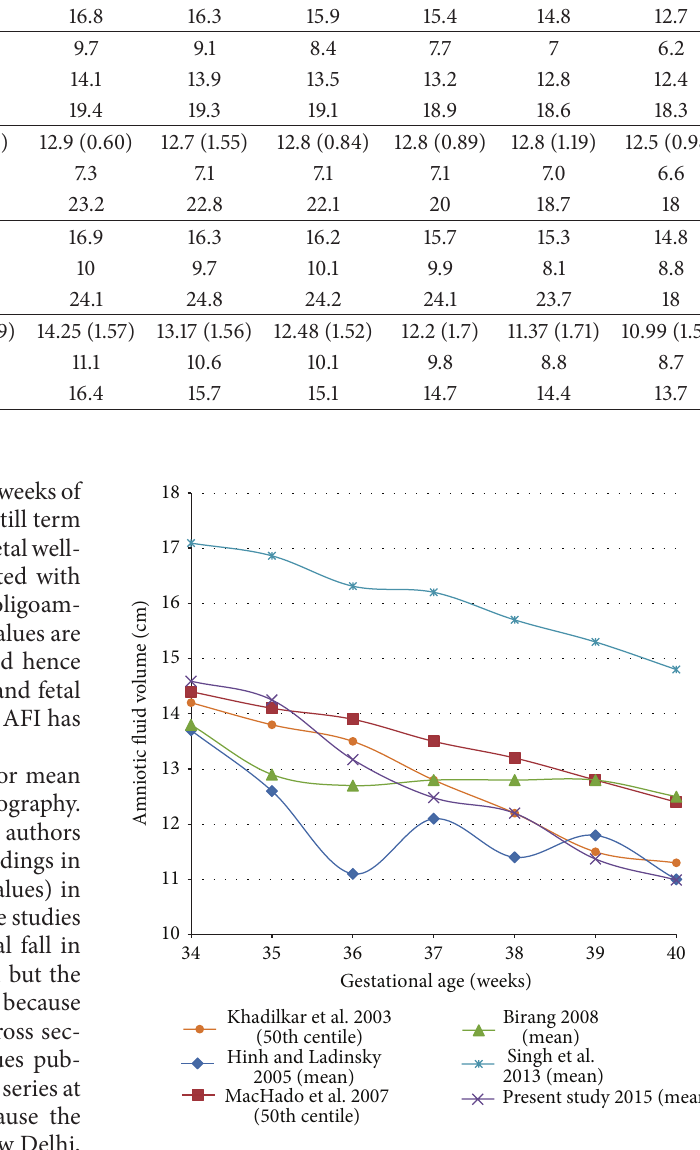
Figure 3: Comparison of AFI values at different gestational ages in various